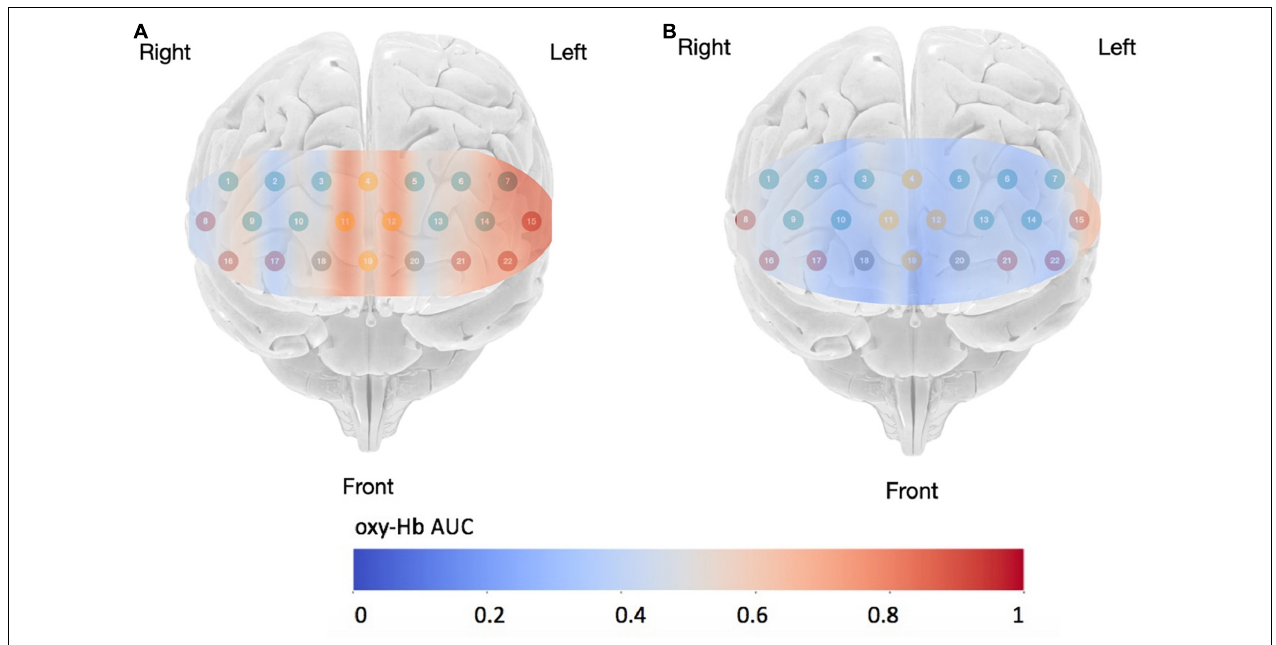
FIGURE 5 | Activation map (AUC) for participants who recommended the green infrastructure: (A) Control group; (B) Intervention group [Base of brain image copyright© Society for Neuroscience (2017)].